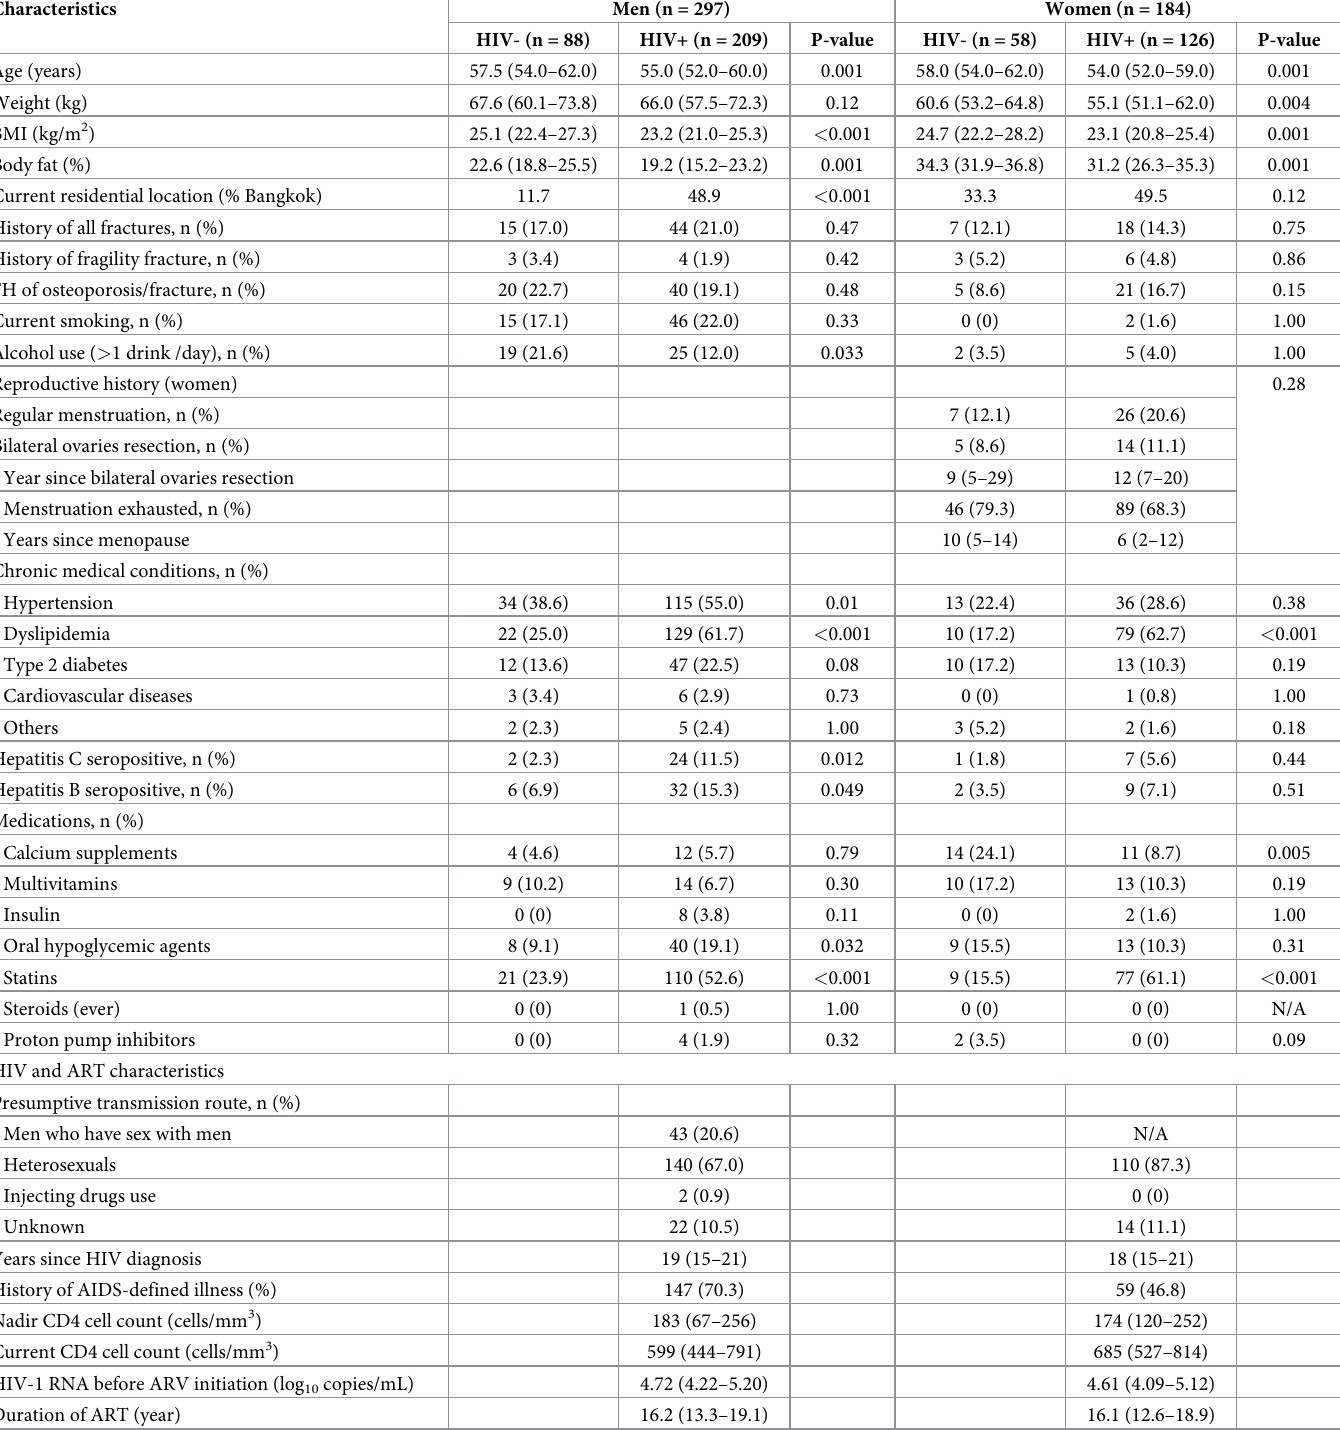
Table 1. Demographic and clinical characteristics of the study population stratified by sex.